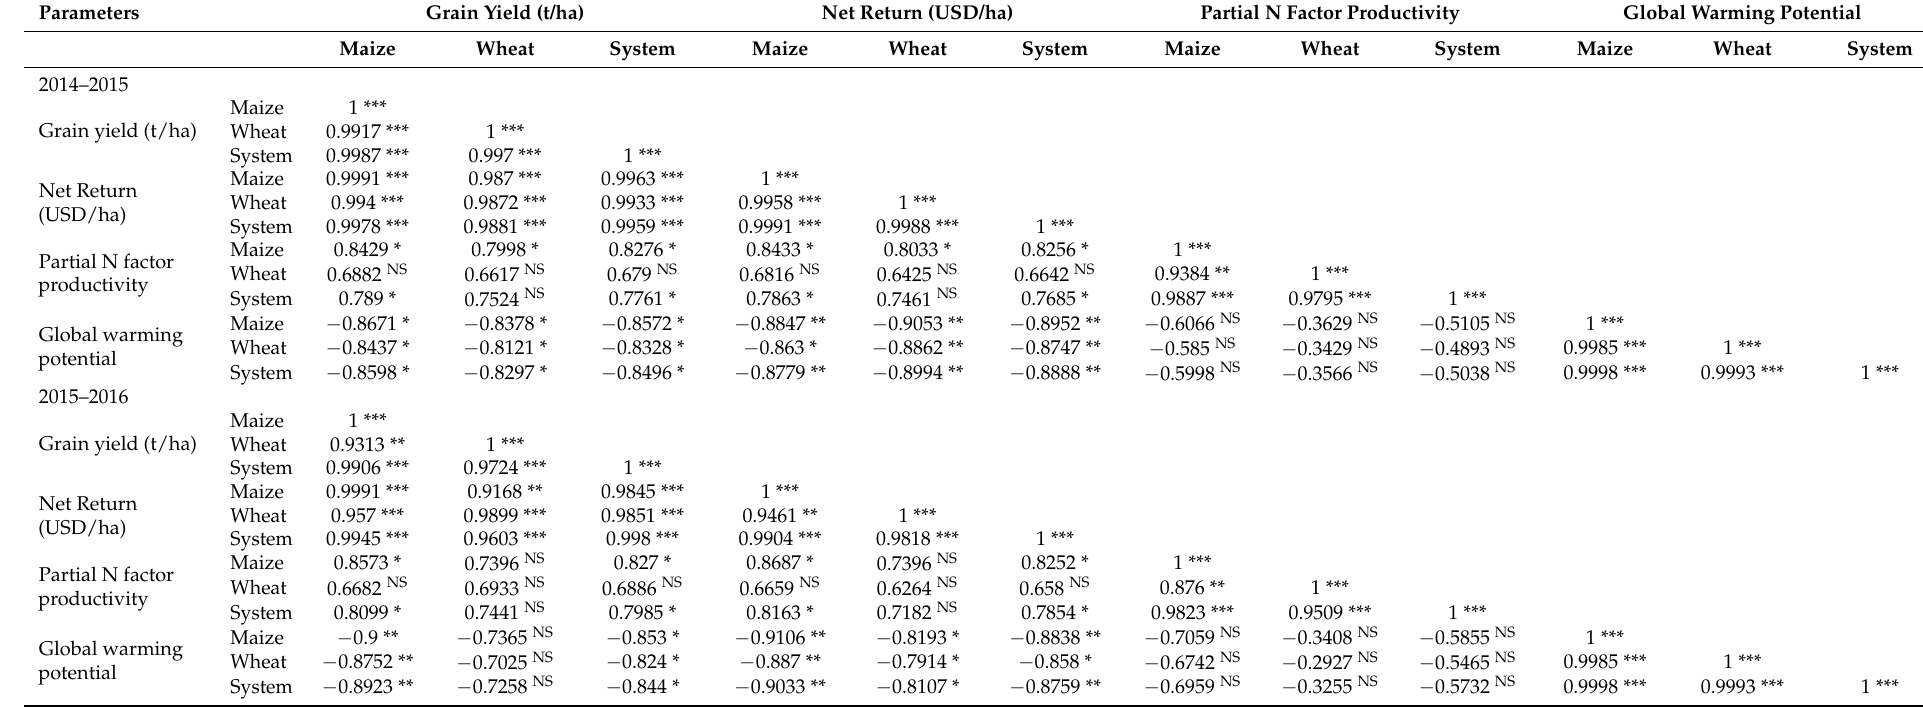
Table 6. Correlation coefficient (r) matrix of different grain yield, net return, partial factor productivity of nitrogen (N) and global warming potential parameters.